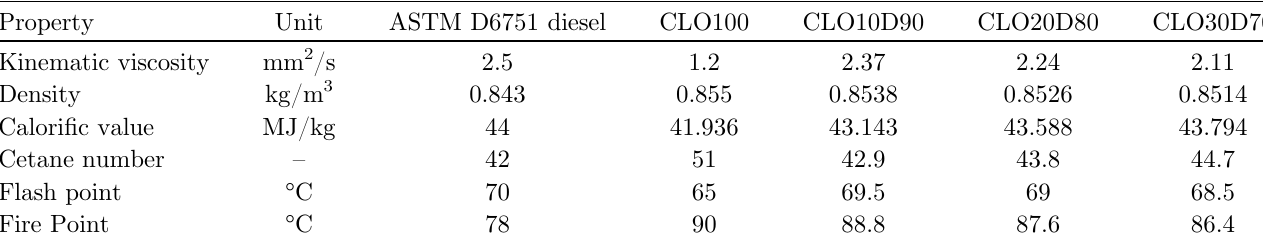
Table 1. Properties of Curcuma longa diesel blends as per ASTM-D-6751 standards. Property